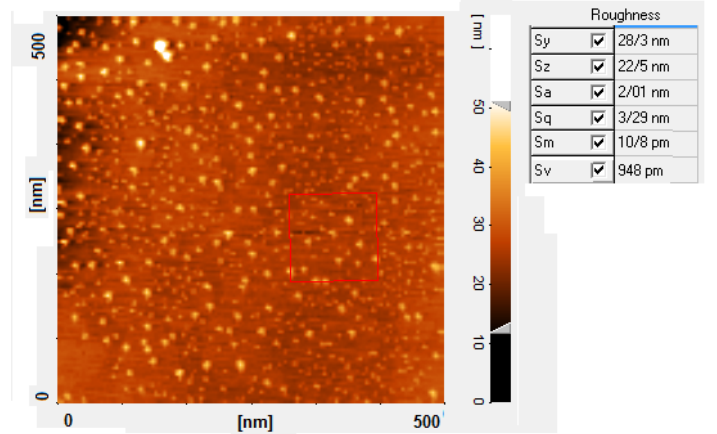
Fig. 7. The surface roughness parameters of WO